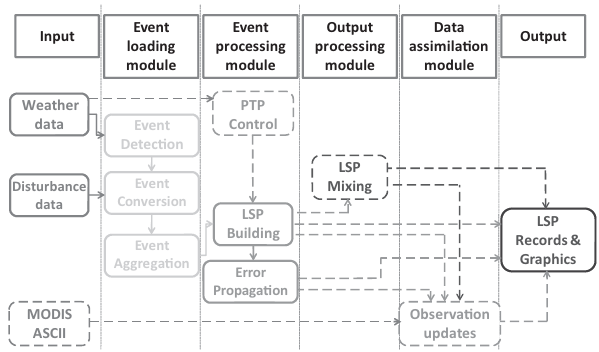
Fig. 1. Workflow diagram of the Event Driven Phenological Model (EDPM) software system (participation of modules with dashed outlines is optional.) Event loading module takes unprocessed in- puts from various sources, converts them in to events and aggregates the events by the day when they occur (See Appendix B for details). Event processing module takes events and builds seasonal trajecto- ries of canopy properties and uncertainties behind them based on knowledge of phenological timing and event response patterns col- lected during the EDPM training (See Appendix C1 and C2 for details). Output processing module applies areal weights (portion cover) to the produced LSP if it is built for a pixel. Data assimila- tion module uses 1DKF scheme to correct predictions with available observations (See Appendix C3 for